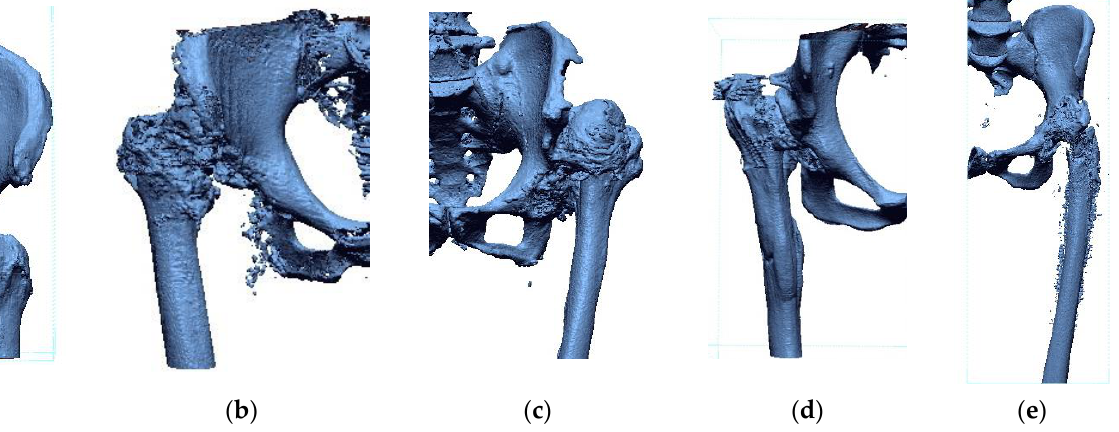
Figure 3. Cases of patients suffering from pathology of the hip joint: ( a ) Patient No. 6; ( b ) Patient No. 7; ( c ) Patient No. 8; ( d ) Patient No. 9; and ( e ) Patient No. 10.